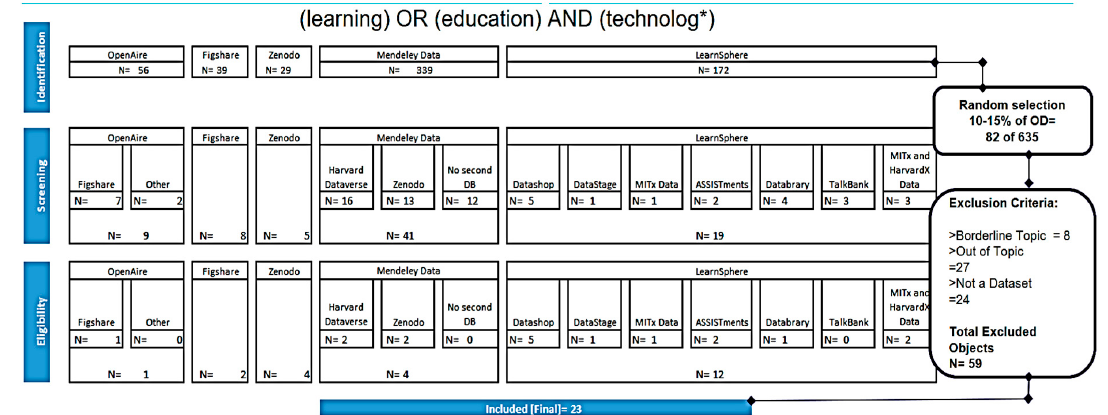
Figure 1. Workflow: Selection of Open Datasets in five Open Data (OD) repositories.